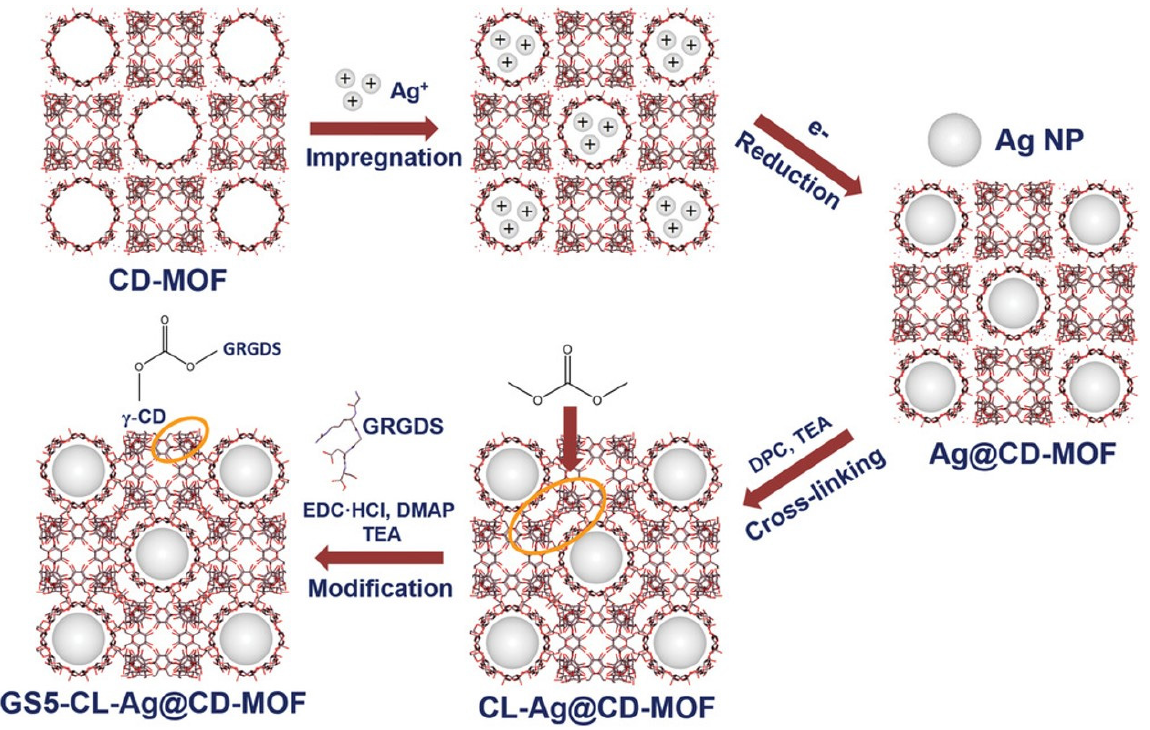
Figure 8. The schematic diagram of the CD-MOF template that guided the synthesis of the Ag NPs by solution impregnation, followed by reduction, cross-linking, and the GRGDS surface modification. Reproduced with permission from [127].